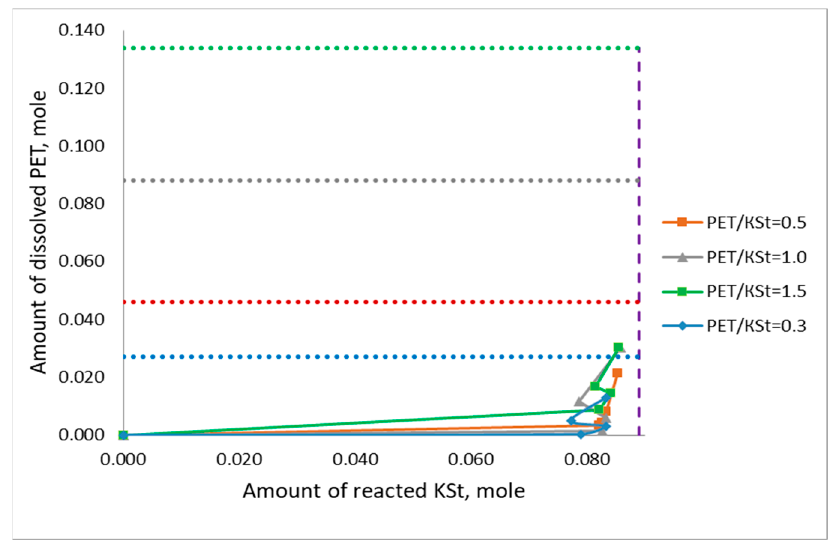
Figure 4. There is a correlation between the decrease in determined potassium ions and the amount of PET dissolved in pure glycerol for different initial molar ratios of PET/KSt at 170 ◦ C. Horizontal lines are total amounts of PET; vertical lines are total amounts of